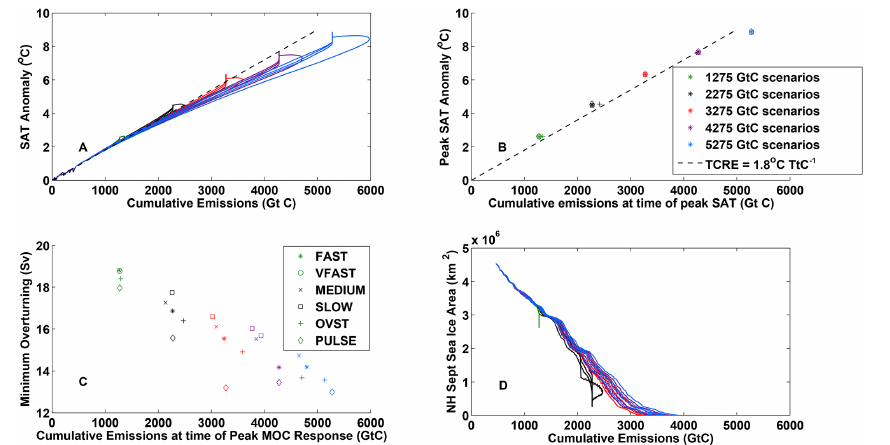
Figure 8. Relationship between physical climate variables and cumulative carbon emissions. (a) Global mean surface air temperature (SAT) anomaly (relative to 1800), (b) peak global mean surface air temperature anomaly (relative to 1800), (c) minimum overturning circulation, and (d) September Northern Hemisphere (NH) sea ice area. The dashed line in (a) and (b) shows the relationship between SAT change and cumulative emissions using the average TCRE computed at the time of CO 2 doubling (1.8 ◦ CTtC − 1 ). Note: the color legend in (b) applies to all panels, and the symbol legend in (c) applies to panels (b) and (c) .